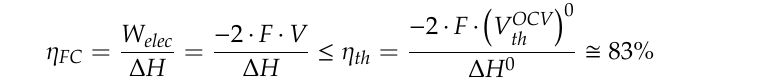
Figure 5. Studied thermodynamic system.